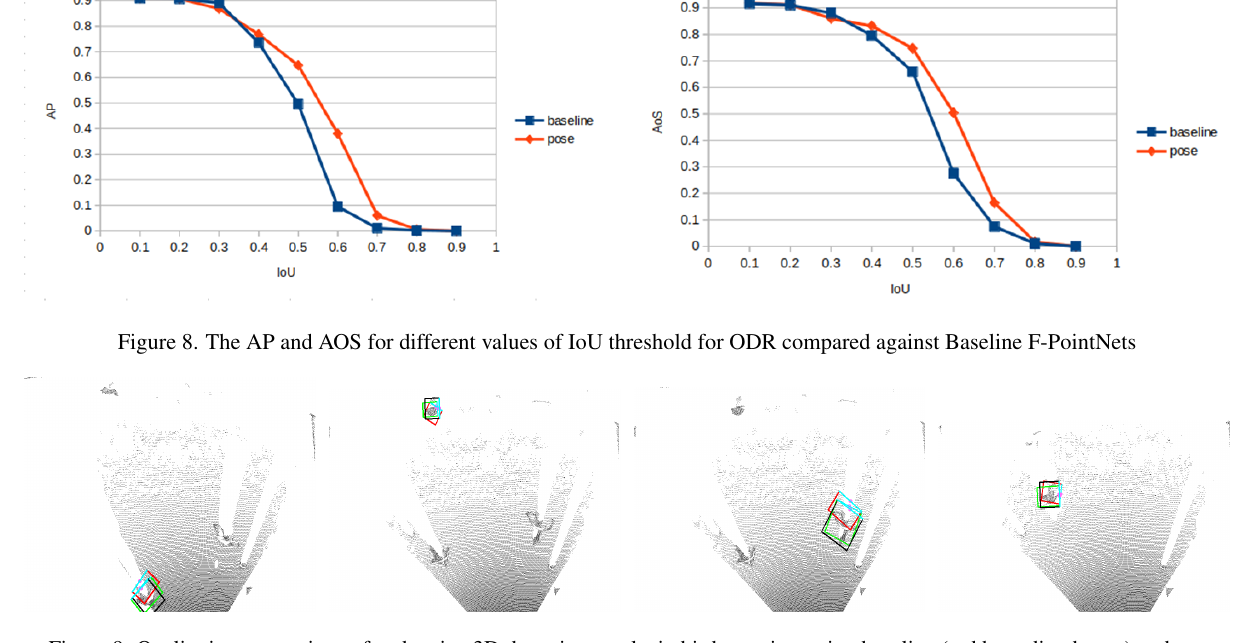
Figure 9. Qualitative comparison of pedestrian 3D detection results in bird eye view using baseline (red bounding boxes) and our proposed approach using ODR features (green bounding boxes). The black bounding boxes are the manually annotated ground truth. The edge in cyan color indicate the frontal orientation of the